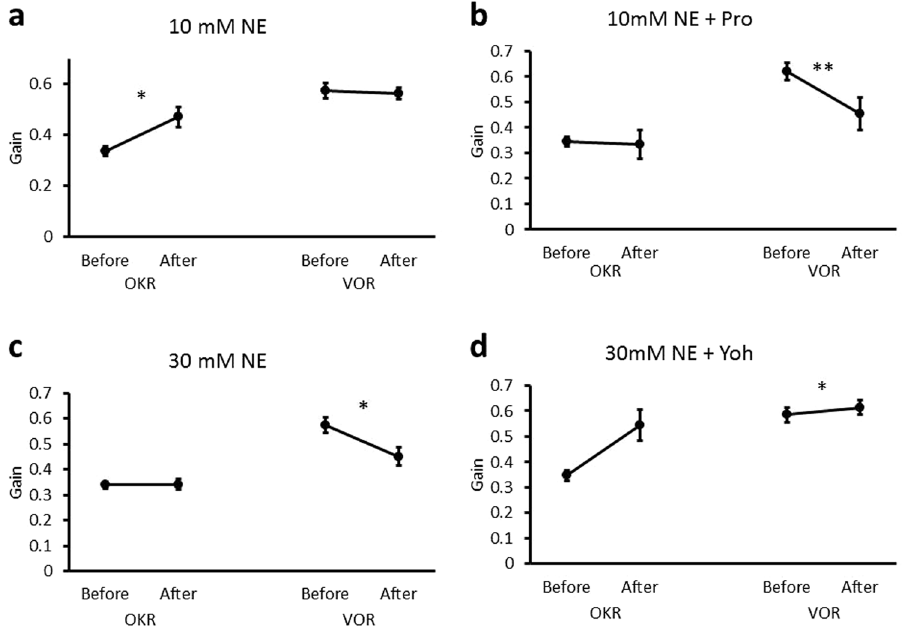
Figure 7. Effects of norepinephrine application on the OKR and VOR gains. ( a,b ), Effects of 10 mM norepinephrine (NE) without ( a ) or with propranolol (Pro) ( b ). ( c,d ) Effects of 30 mM norepinephrine without ( c ) or with yohimbine (Yoh) ( d ). Error bars indicate SEM. * p < 0.05, ** p < 0.01, paired Student’s